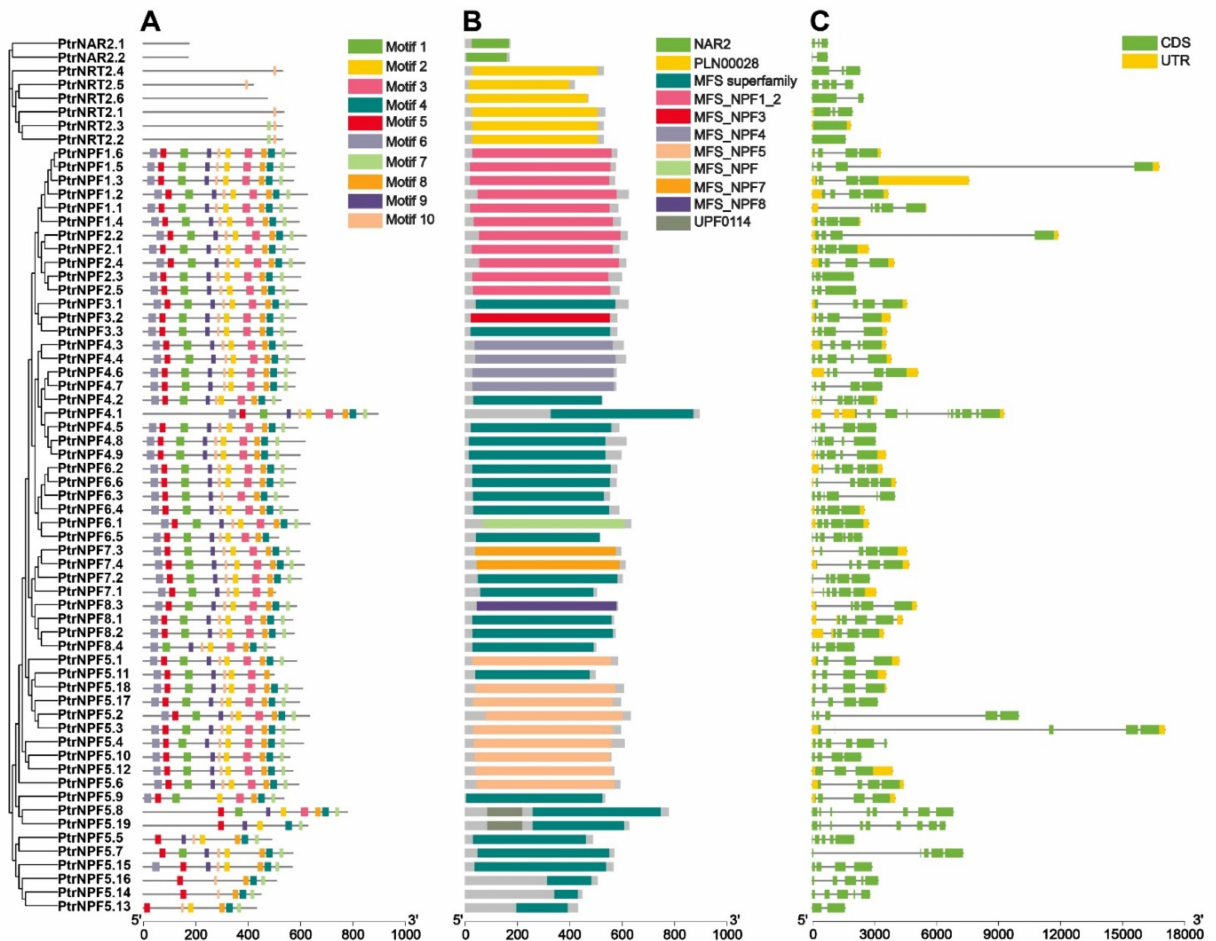
Figure 3. Motif, conserved domain, and gene structure analysis of PtrNRT genes. ( A ) The motif analysis was performed on the MEME (https://meme-suite.org/meme/doc/meme.html, accessed on 1 March 2022). Ten motifs were identified. The detail of motif sequence information was presented in supplemental Figure S1. ( B ) The conserved domain analysis was performed through the NCBI Batch CD-search tool. ( C ) The gene structure analysis. The yellow color was the untranslated region, while the green was the coding sequence. The line without color referred to